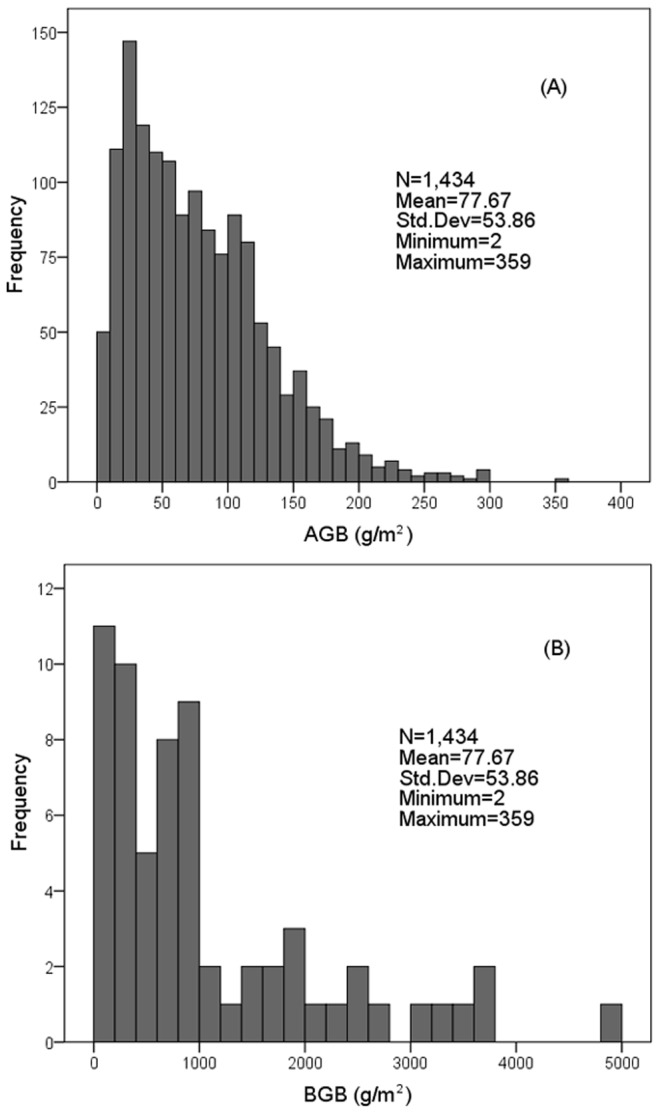
Frequency distributions of the AGB (A) and BGB (B) based on field measurements.The number of AGB–BGB samples is 9 for the temperate meadow steppe and low-land meadow (in the eastern part of Xilingol), 33 for the temperate steppe (the middle part of Xilingol) and 22 for the temperate desert steppe (the western part of Xilingol). The BGB data reported in previous publications were mostly sampled during the summers (July to September) of 2001 to 2005 (Yang et al., 2010).